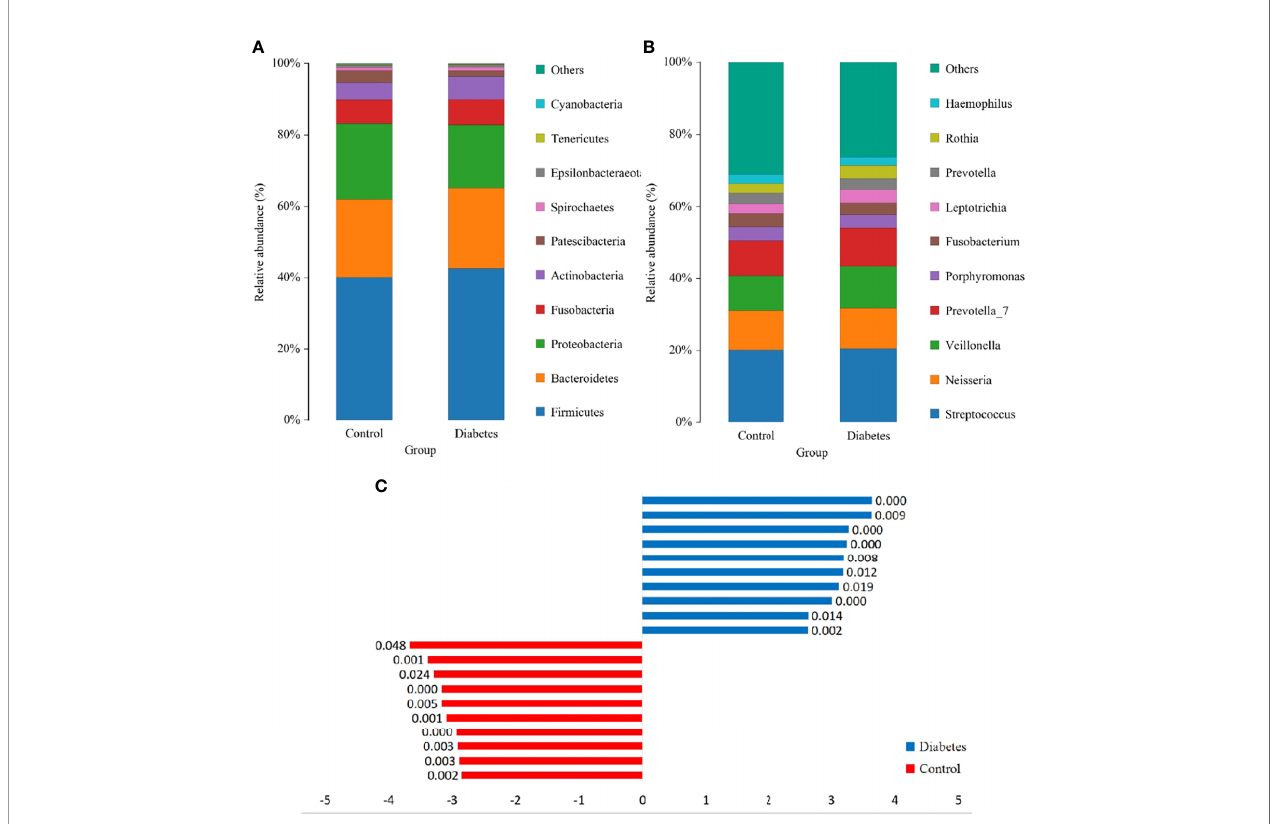
FIGURE 3 | The structure analysis of the microbial community. (A) and (B) are the bar graphs of microbial abundance at the phylum and genus levels, respectively. (C) LDA bar graph. Blue and red bars represented LDA values for taxa enriched in the T2DM group and those enriched in the healthy controls with p -values labeled next to the bars,